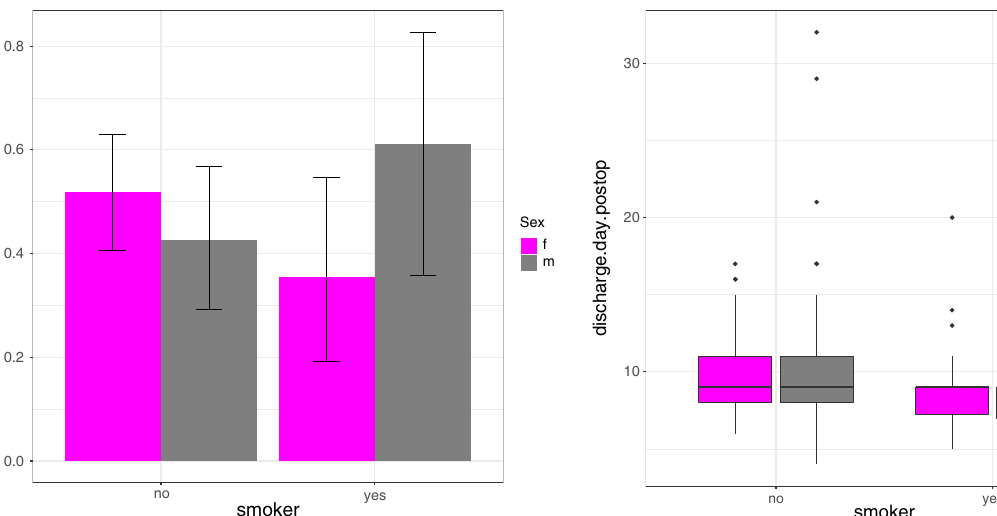
Figure 3: The postoperative complication rate in female and male smokers.